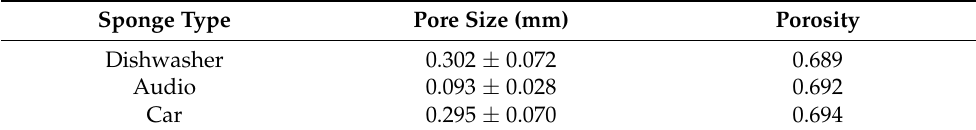
Table 1. Properties of sponge samples found using an SEM device.